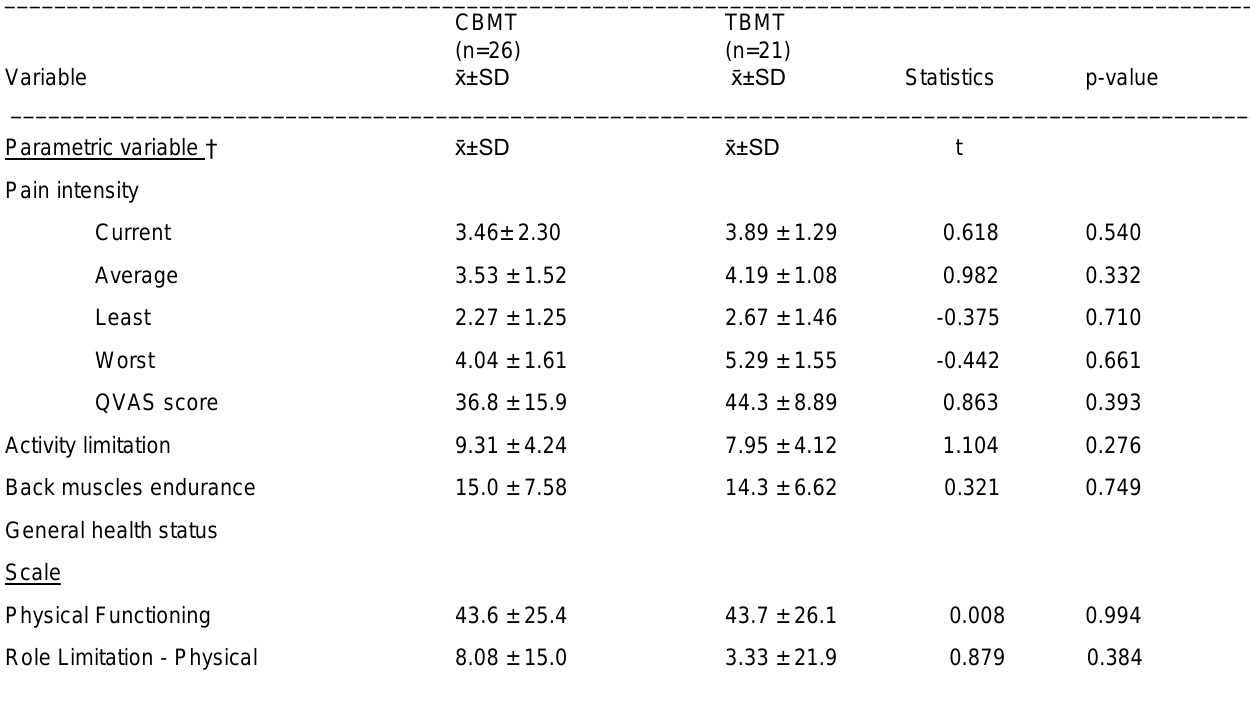
Table 7. Comparison of Participants’ Treatment Outcomes (Mean Change – i.e., Week Eight minus Baseline) for the Continuous Variables at Week 8 of the